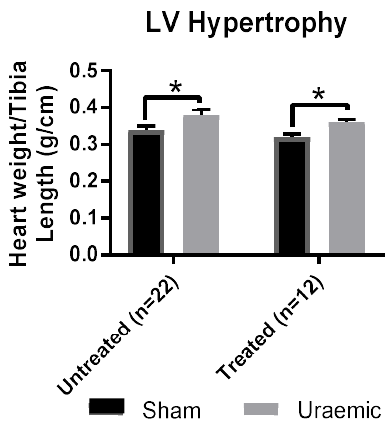
Figure 2. Cardiac hypertrophy 12 weeks post-surgical induction of uraemia was evaluated by measurement of heart weight to tibia length ratio in uraemia and sham animals with and without iv iron. Data are presented as mean ± SEM (* p < 0.05).